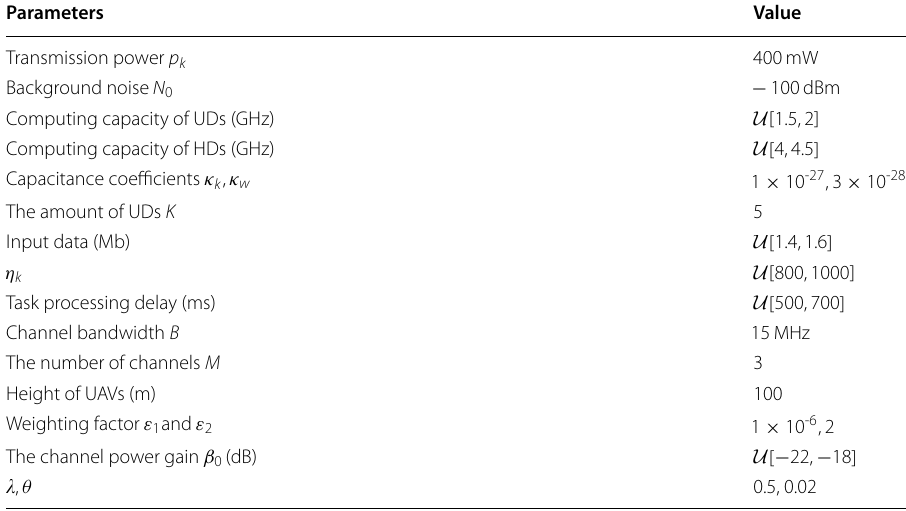
Table 1 Simulation parameters setting